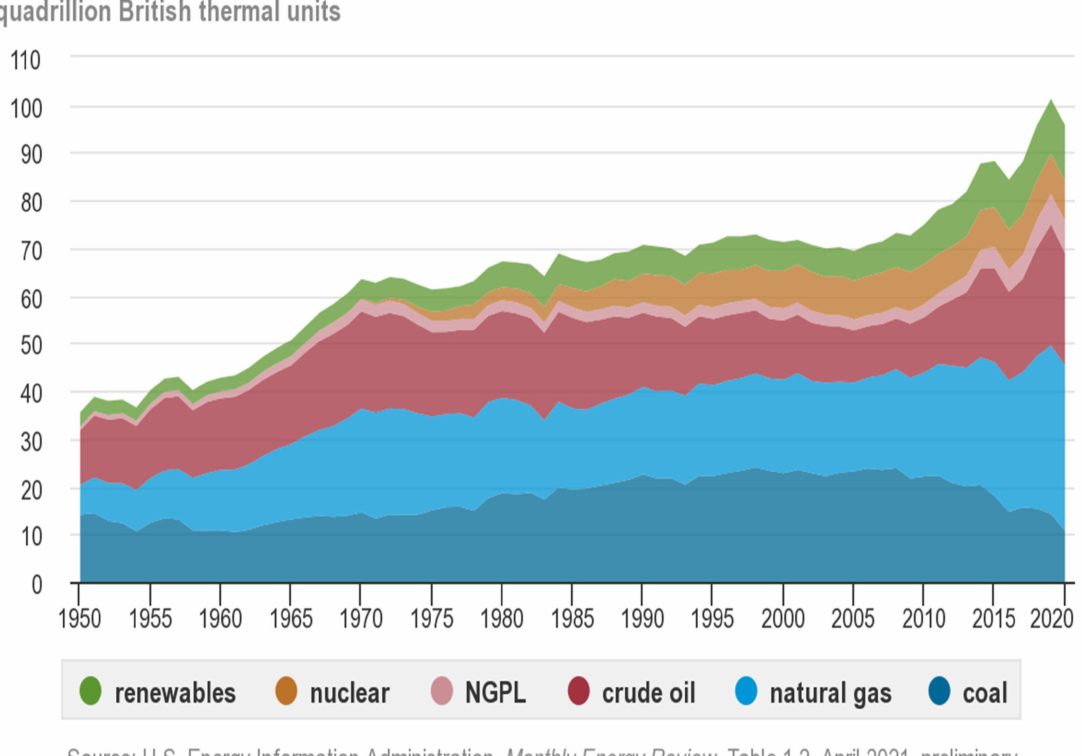
Figure 2. Energy production by